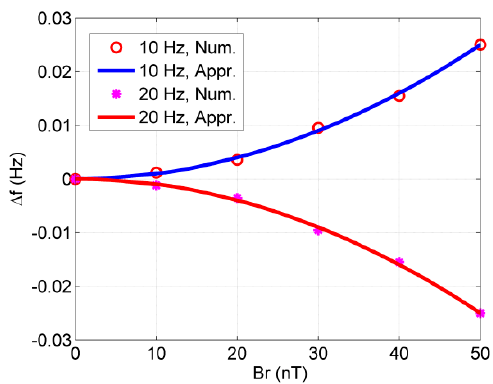
Figure 4. The frequency shift vs. B r for di ff erent frequencies of the Cross-Axis-Rotation-Equivalent